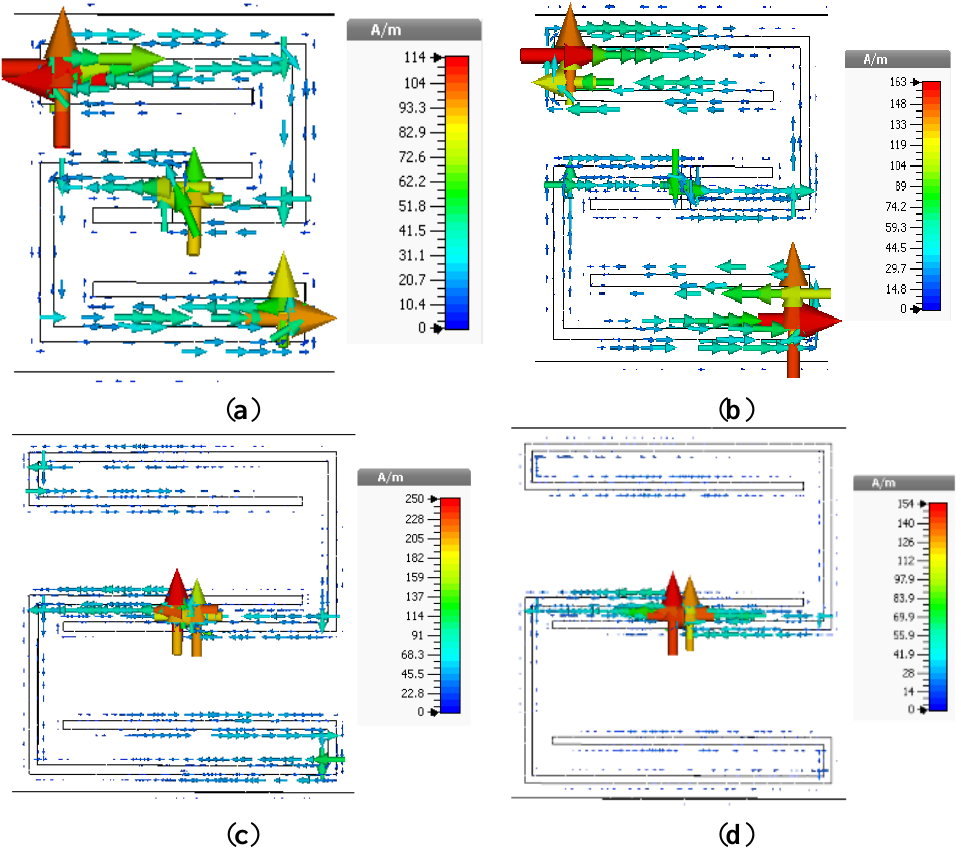
Figure 4. Surface current distributions of unit cells at 3.5 GHz, ( a ) unit cell A; ( b ) unit cell B; ( c ) unit cell C; and ( d ) unit cell D.